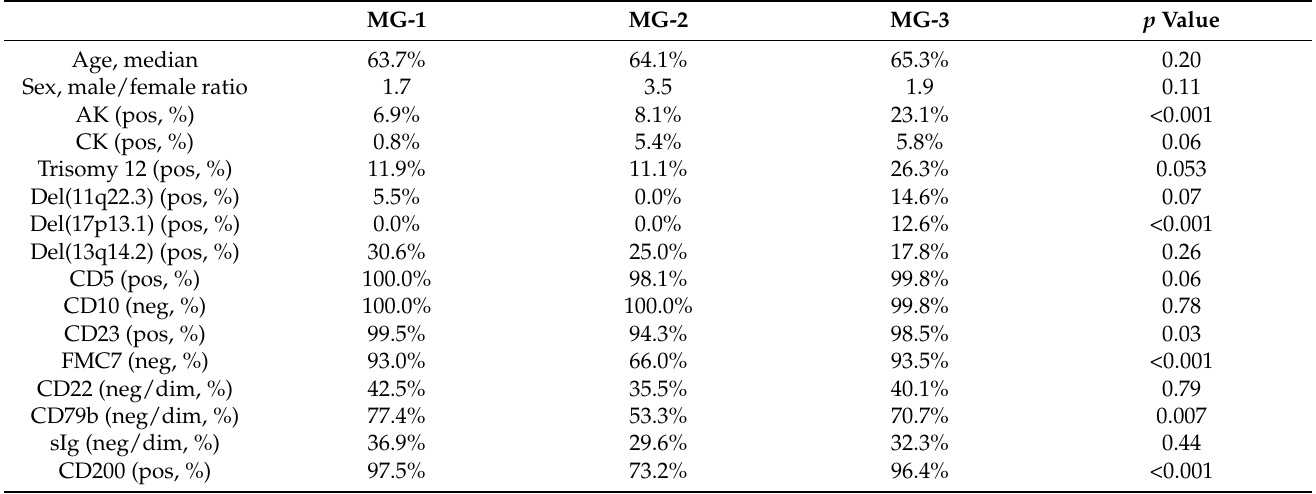
Table 3. Cytogenetic aberrations and immunophenotypes distribution among the three molecular